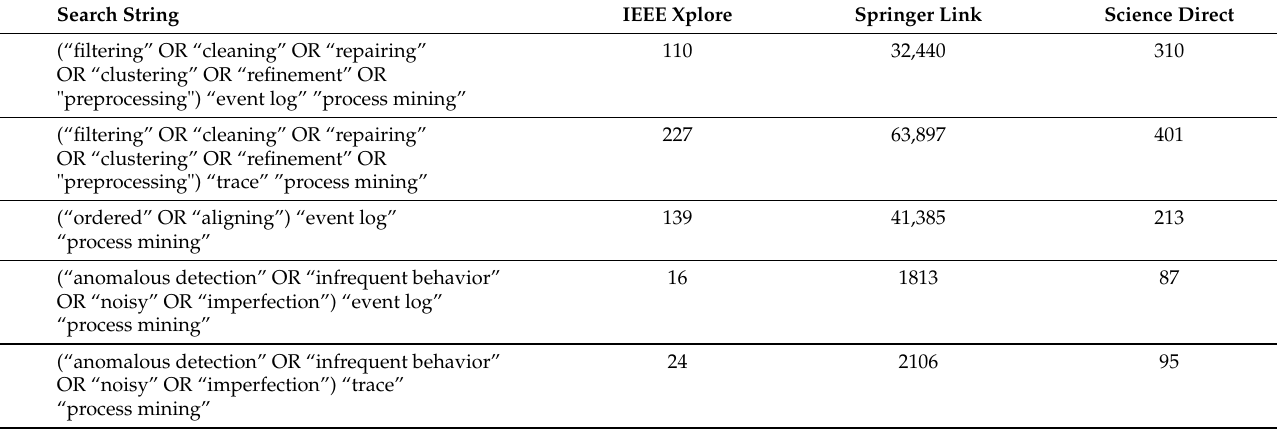
Table 1. Query details and results (number or retrieved papers) from the selected digital